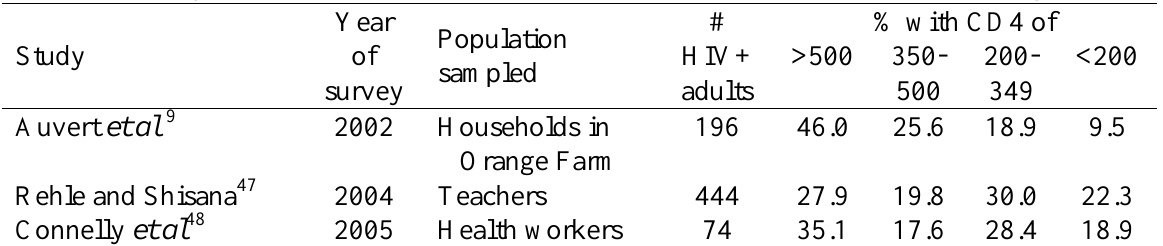
Table 4: Survey estimates of proportions of HIV-infected adults in different CD4 stages